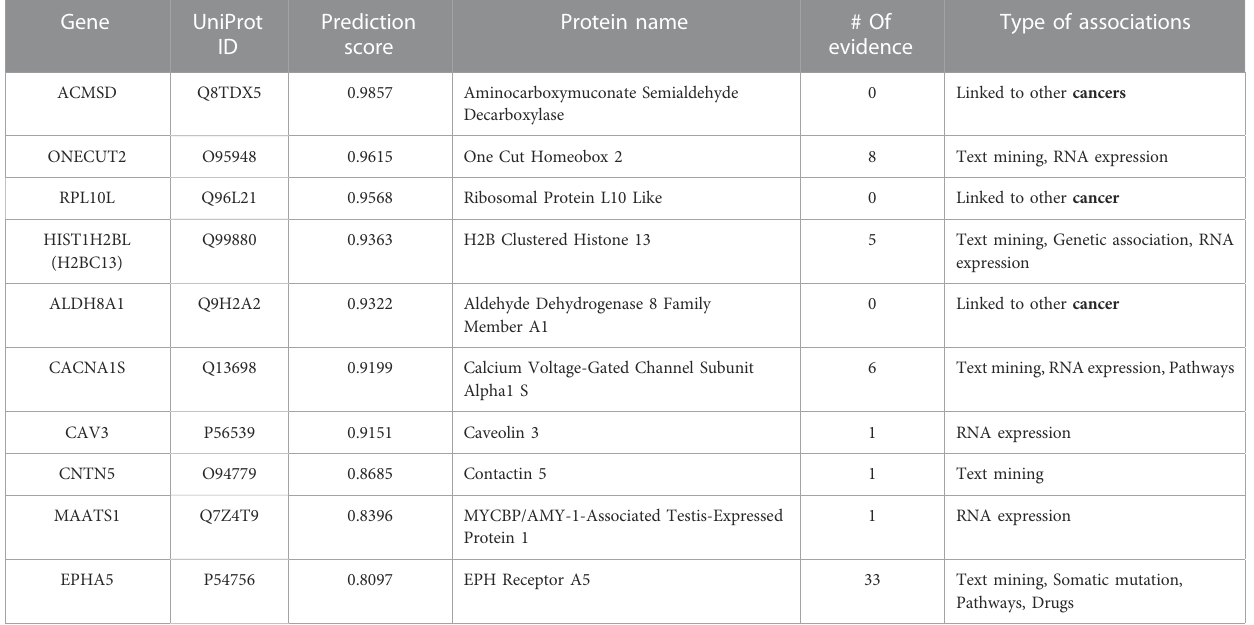
TABLE8Top10-rankednovelpredictedtherapeutictargetsbasedonthepredictionscoreforlung cancerwiththenumberandtypeofevidencelinkingthetargetsand